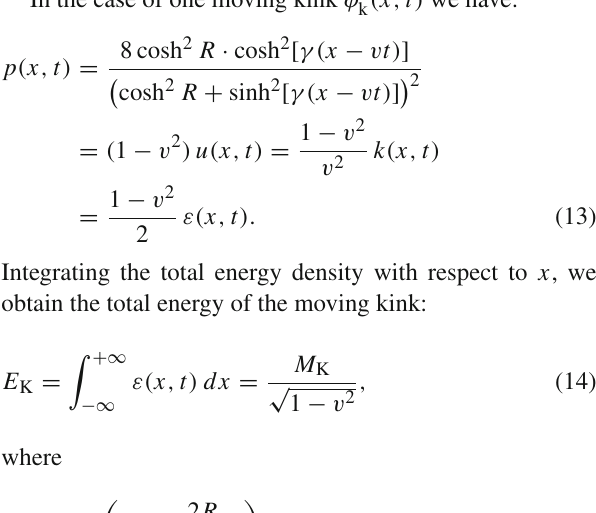
( x ) )andantikinks k ( x ) ) of the DSG model for three k